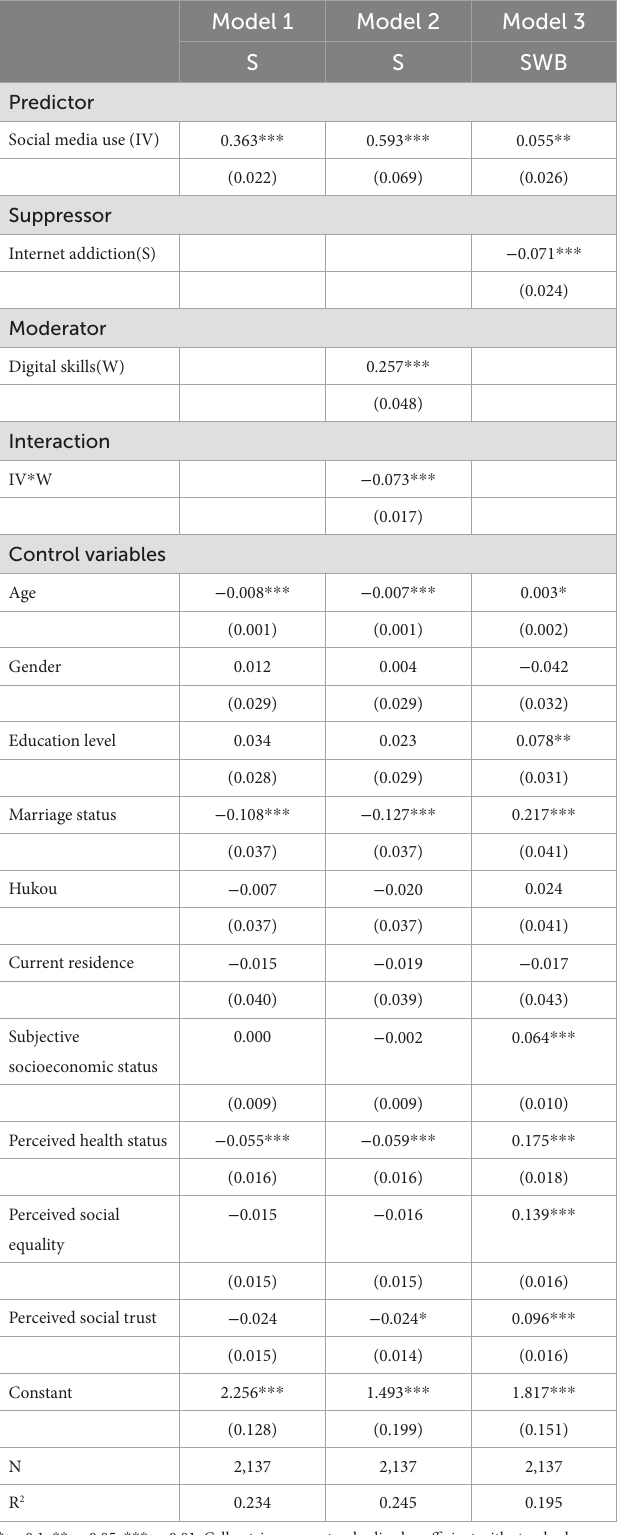
TABLE 3 Results of the mediation model and moderation model regression